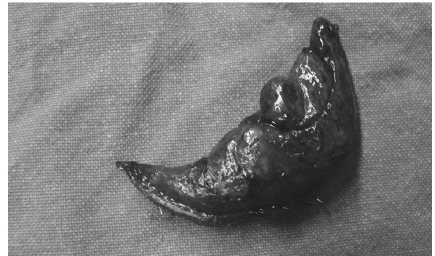
Figure 3: Resected